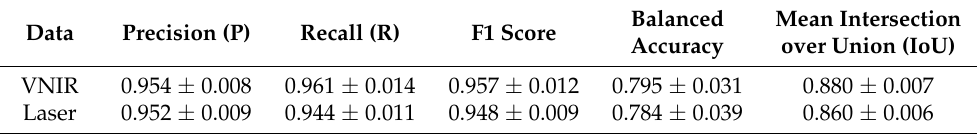
Table 3. Mean results and standard deviation of the metrics for predicting coating adhesion for both HSI datasets. The best value in each case is underlined. The metrics are calculated on the test data